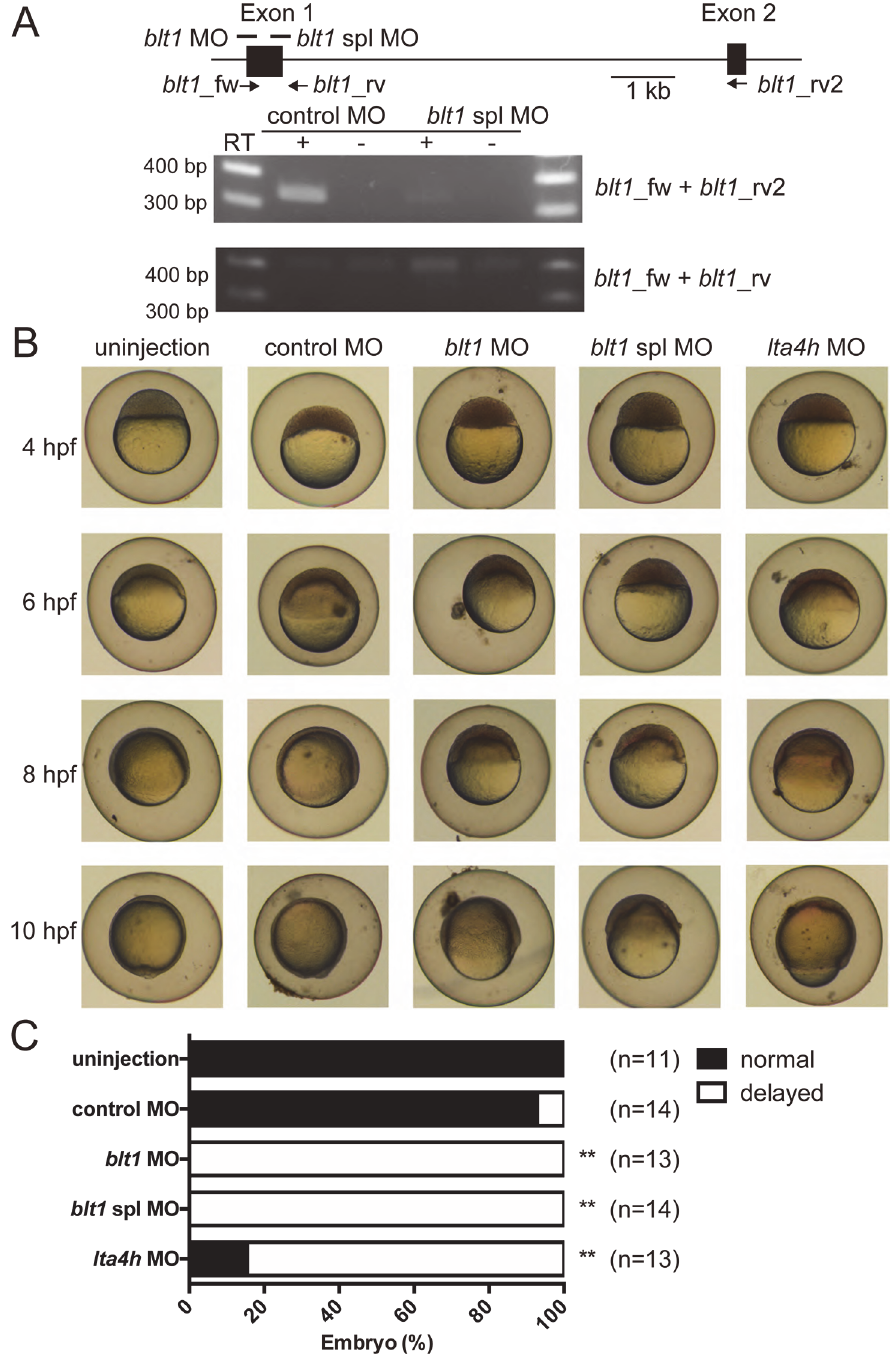
Fig 10. Morpholino-mediated knockdown of blt1 and lta4h affects epiboly. (A) Diagram of a partial map of blt1 genomic DNA. Exons and introns are shown as boxes and lines, respectively. Two nonoverlapping blt1 MOs, blt1 MO and blt1 spl MO, were designed to target translation and splicing of Blt1, respectively. The blt1 MO should eliminate the transcription of exon 1, which contains the translation start site, resulting in aberrant protein synthesis. The efficacy of blt1 spl MO was validated by RT-PCR using blt1 _fw and blt1 _rv or blt1 _rv2. Total RNA was isolated from blt1 spl MO or control MO-injected embryos at 24 hpf. Reduced expression of normal spliced blt1 transcripts and increased mis-spliced blt1 transcripts are shown. (B) Representative images of delayed epiboly of blt1 and lta4h morphants from 4 to 10 hpf. Embryos